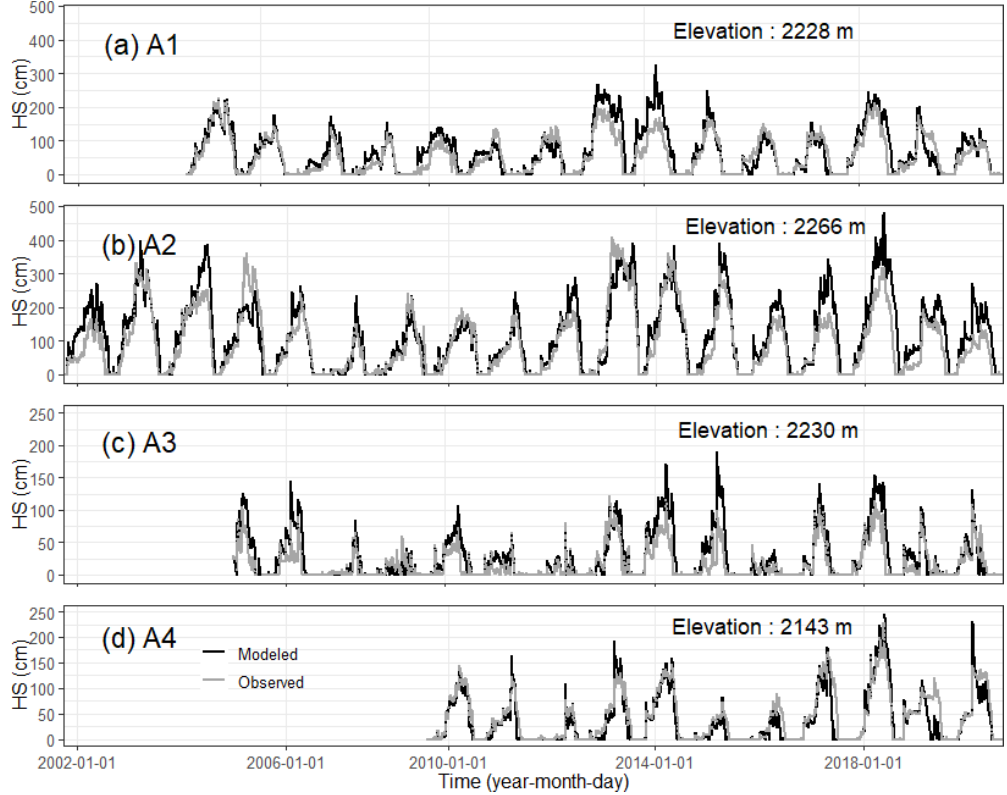
Figure 2. Time series of the observed (gray) and modeled (black) HS values at the four AWSs.